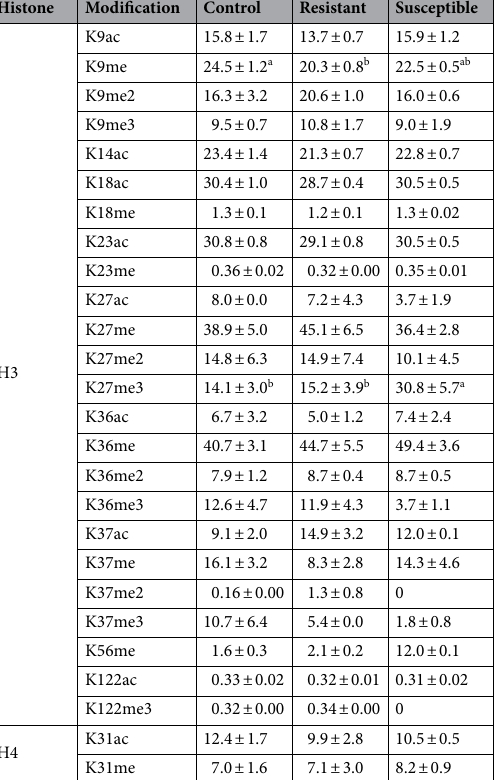
Table 3. Summary of quantified PTMs on histones H3 and H4*. *The modification site, type, and relative abundance (%) of each PTM are expressed as the mean ± standard error (n = 5) without missing values. Data were analyzed using the least squares means method and Kruskal–Wallis test. a,b Superscripts indicate a difference between groups within the same PTMs ( P < 0.05).